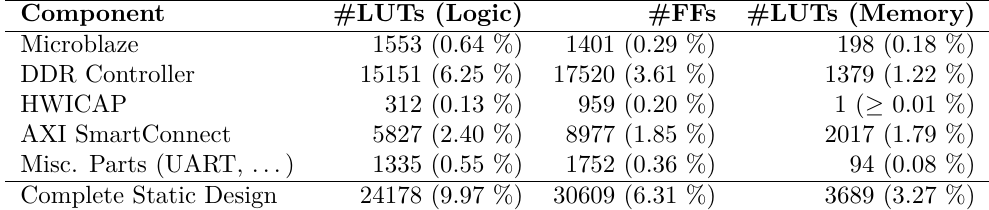
Table 1: Hardware design resource utilization of the Hardware Nanomites static design parts synthesized for a xcku040-2ffva1156e . Note that the complete static design also includes components for the bitstream streaming such as a UART IP core.